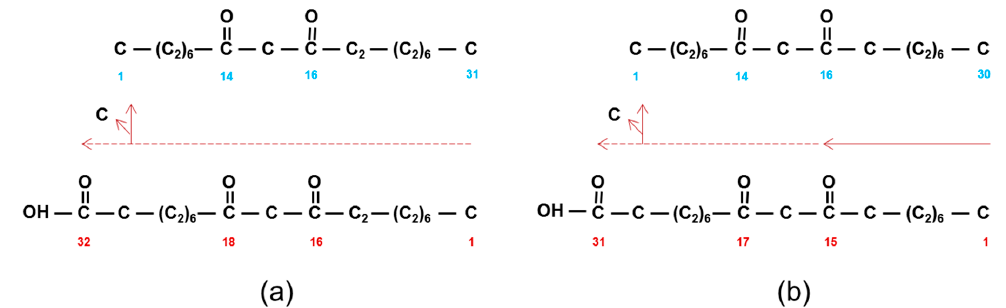
Figure 1. Structure and IUPAC (blue) nomenclature of β -diketones compared to their biosynthetic nomenclature (red). ( a ) Hentriacontane-14,16-dione (C 31 ) is derived from 16,18-dioxodotriacontanoic acid by loss of a carbon. Horizontal dashed red arrow denotes direction of synthesis by successive additions of C 2 -units.